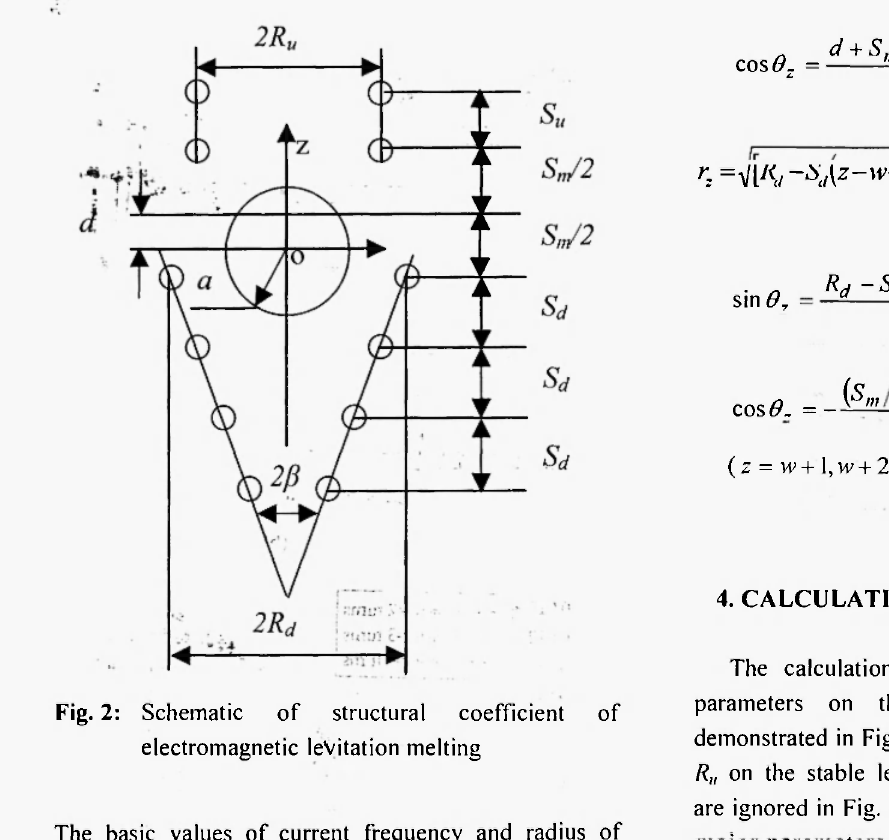
Fig. 2: Schematic of structural coefficient of electromagnetic leVitation